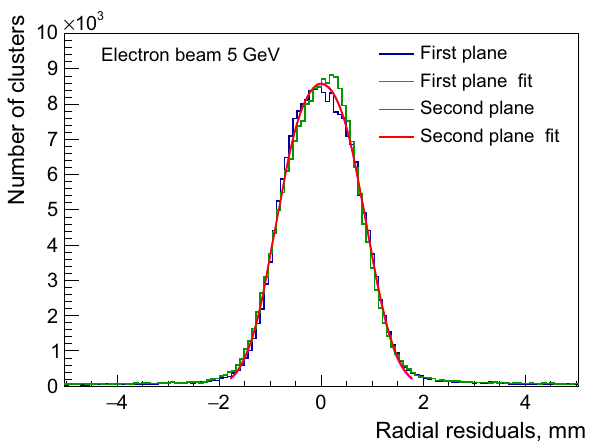
Fig. 17 Distributionofresidualsoftheradialpositionmeasurementsin the tracking planes and the calorimeter, obtained with a 5 GeV electron beam position is not in the centre of a pad. Several methods were developed to achieve more accurate position reconstruction, and the following choice of weights is found to be the most